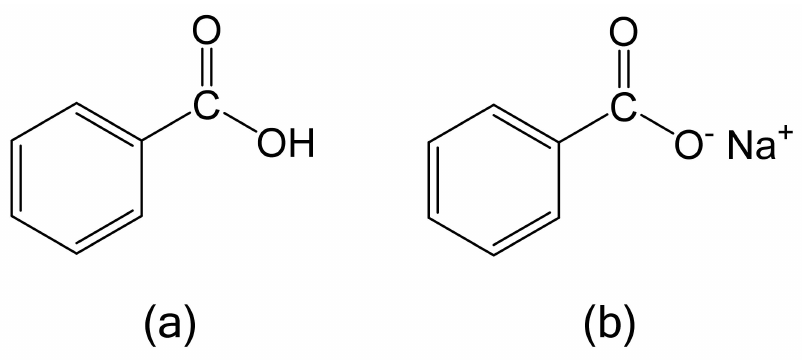
Figure 1. The molecular structure of ( a ) benzoic acid and ( b ) sodium